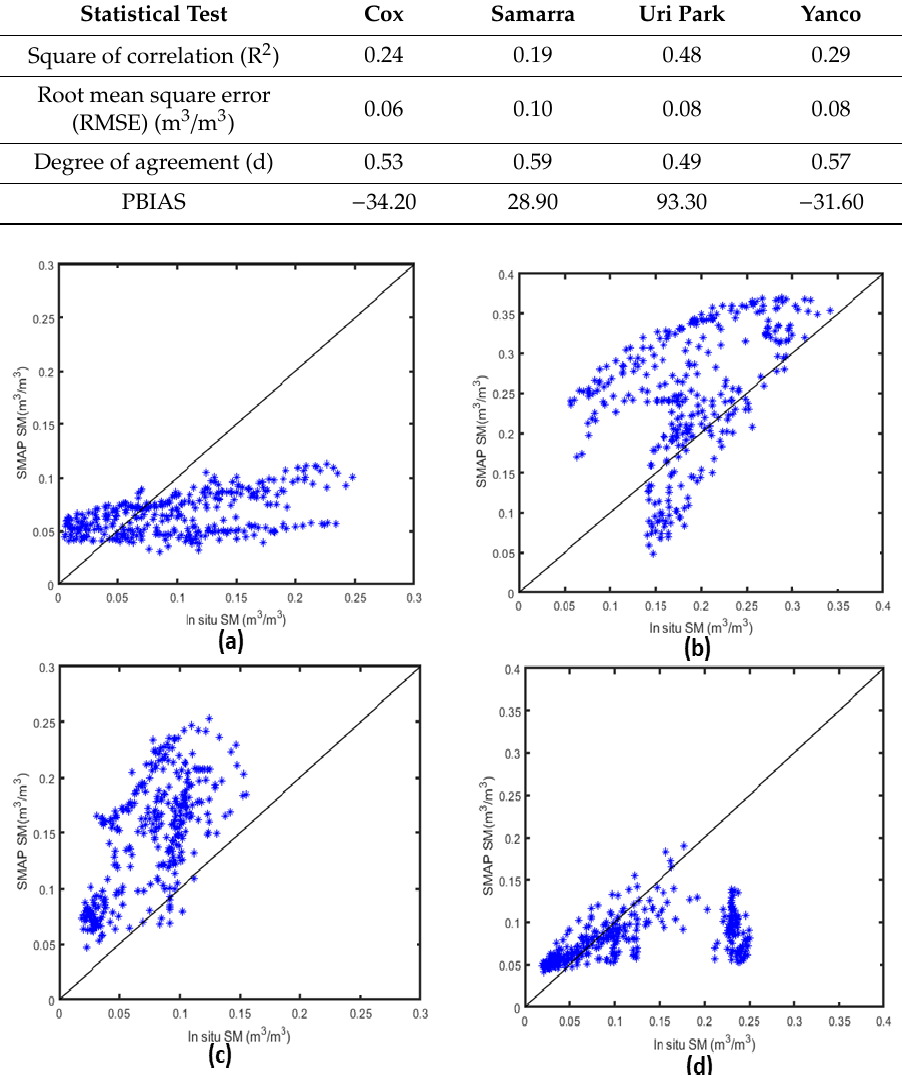
Figure 9. Comparisons between the SMAP SM and in situ SM for ( a ) Cox ( b ) Samarra ( c ) Uri Park and ( d ) Yanco, Australia.